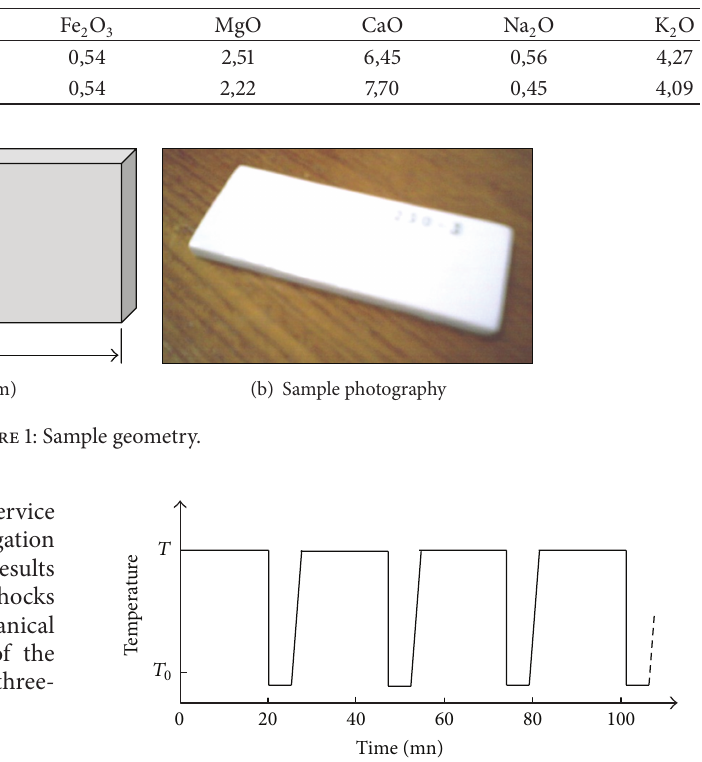
Figure 2: Thermal shock cycle applied to